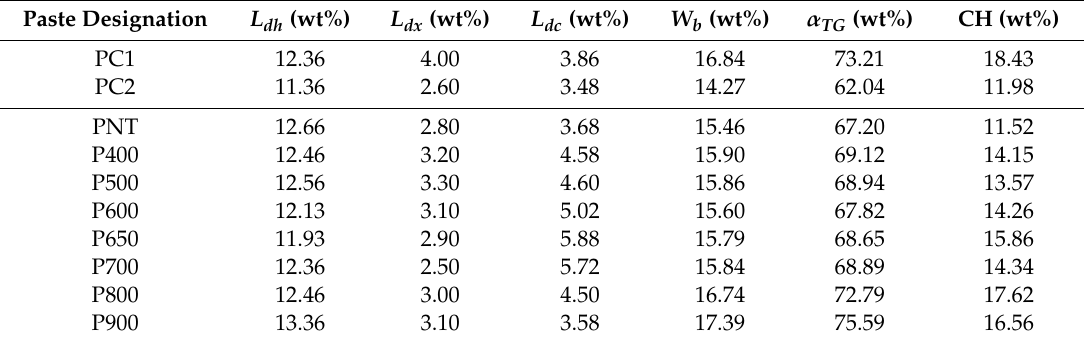
Table 8. Estimated L dh , L dx , L dc , W b , α TG and CH contents of PC, PNT and RC pastes at 28 days.